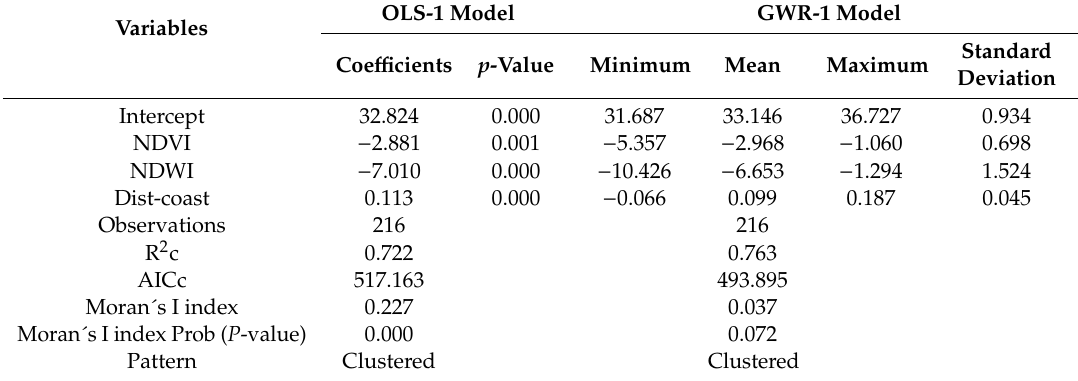
Table 1. Results for the first ordinary least squares (OLS) and geographically weighted regression (GWR) models.